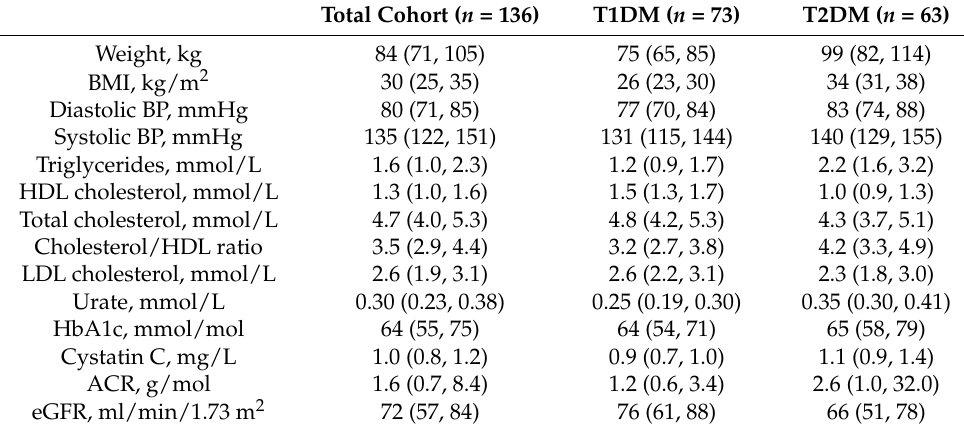
Table 2. Physiological and biochemical parameters of the